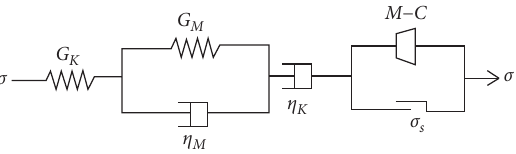
Figure 7: The creep model of Figure 8. The model curve of the Cvsic model is in good